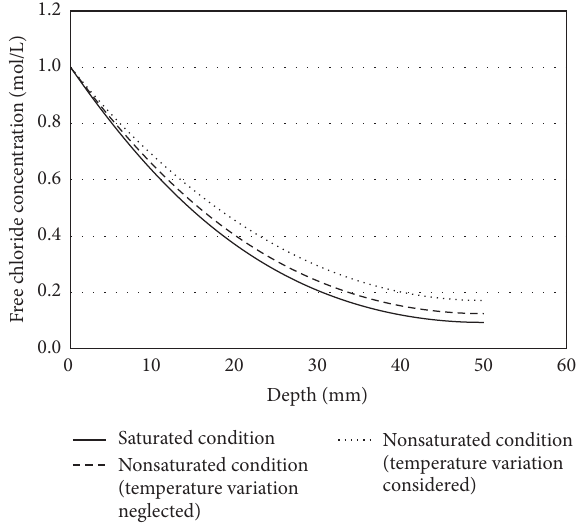
Figure 8: Free chloride concentration profiles at 100 days of expo- sure.